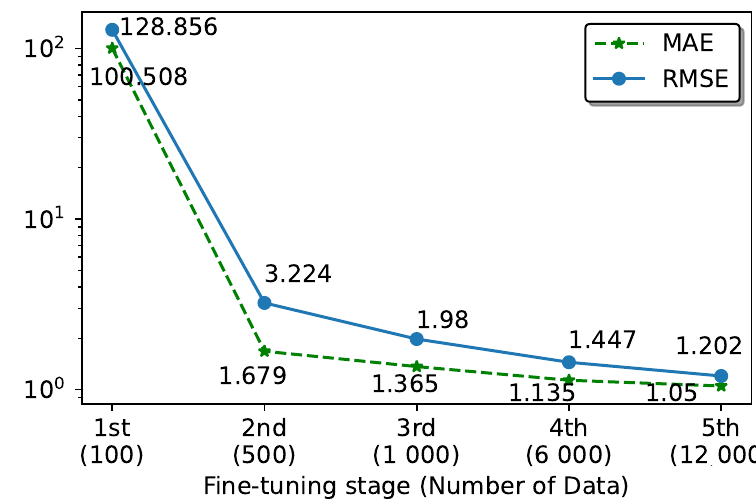
Figure 11. Staged fine-tuning